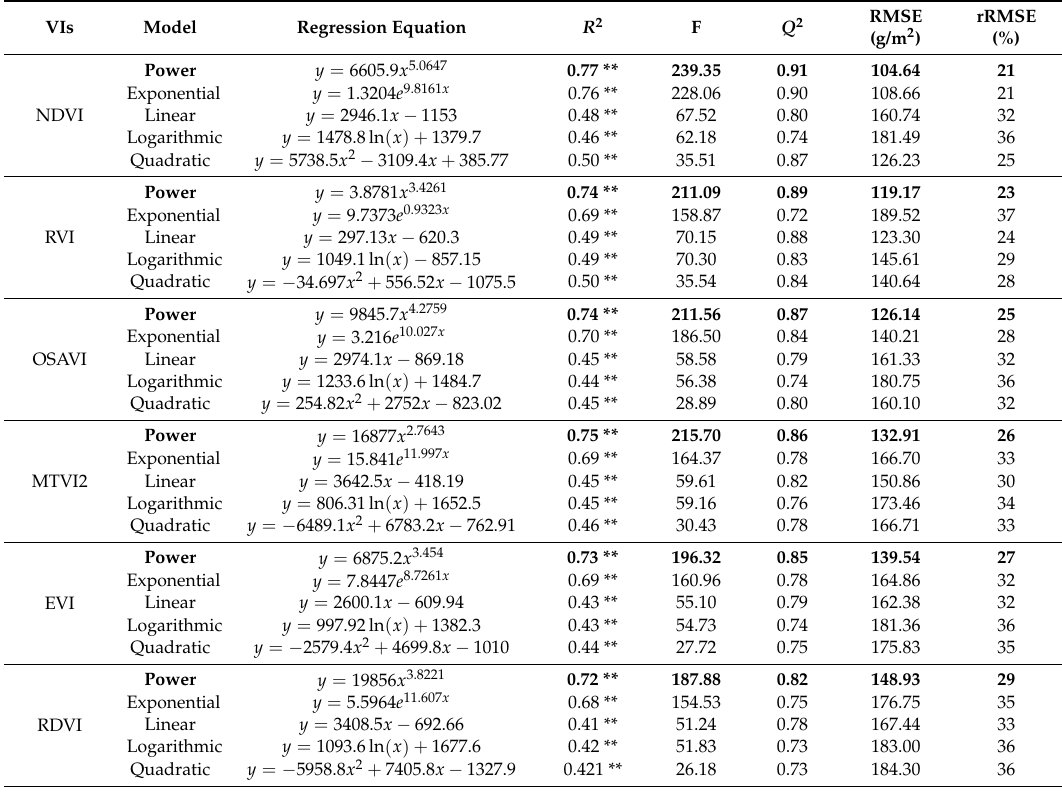
Table 6. Regression analysis between above-ground biomass (AGB) and the selected vegetation indices (VIs) for winter oilseed